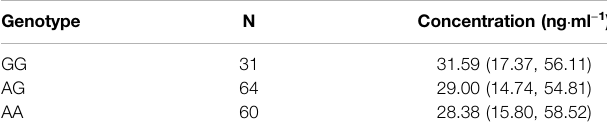
TABLE 5| Effect ofrs4148738SNPsonrivaroxabanserum concentrationsin155 recipients.